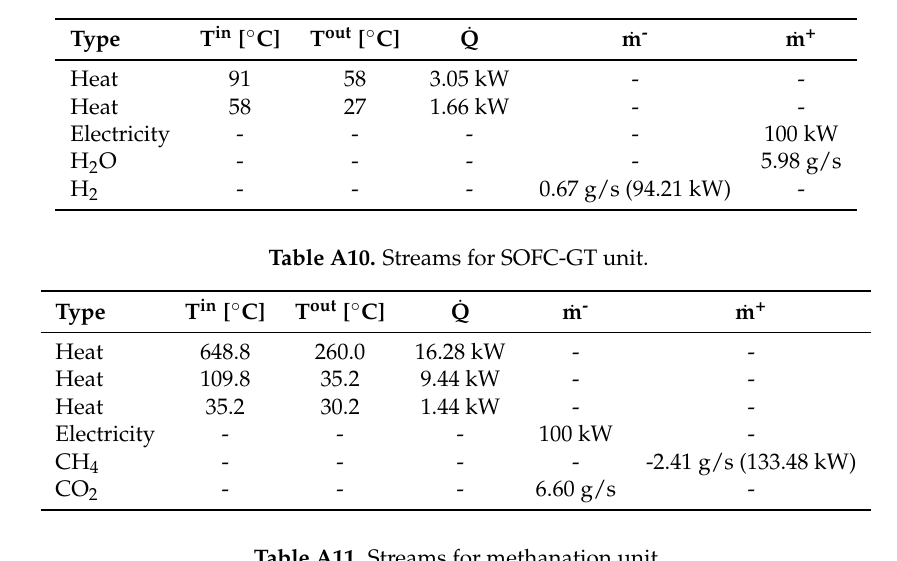
Table A9. Streams for SOEC unit.